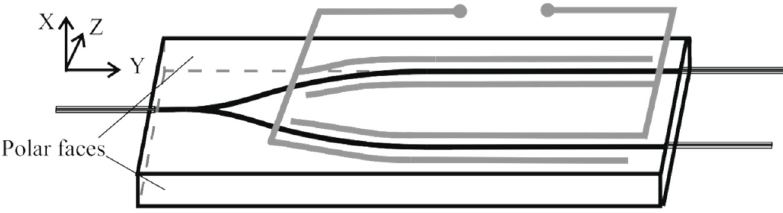
Figure 1. Topology of the waveguides of the phase modulator. Black lines are optical waveguides, grey lines are surface electrode system.